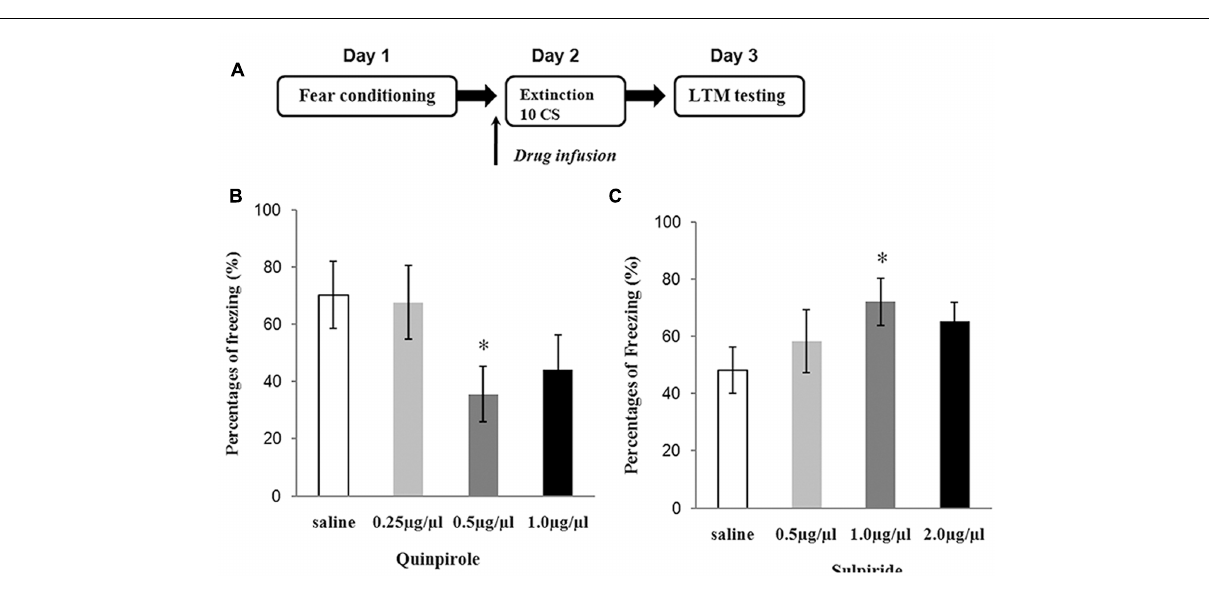
FIGURE 2 | Experiments to determine the optimal doses of sulpiride and quinpirole. (A) Protocol for dose-determining experiments. (B) Average freezing during five CS presentations in the test for quinpirole ( ∗ P < 0.05) ( n = 6 or 7/group). (C) Average freezing during five CS presentations in the test for sulpiride ( ∗ P < 0.05) ( n = 6 or